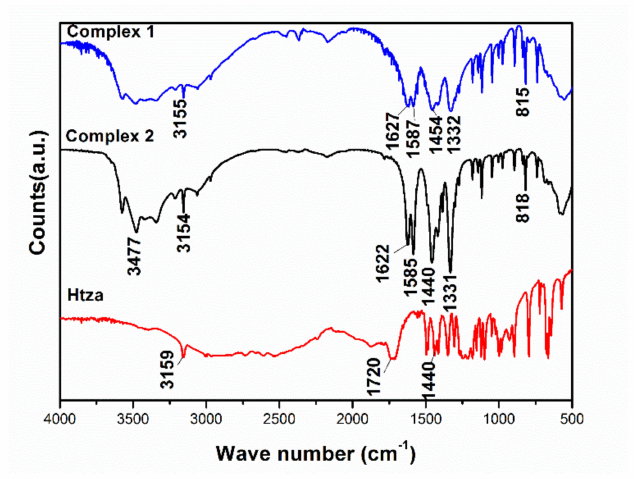
Figure 3. FTIR spectra of Htza, complex 1 , and complex 2 .